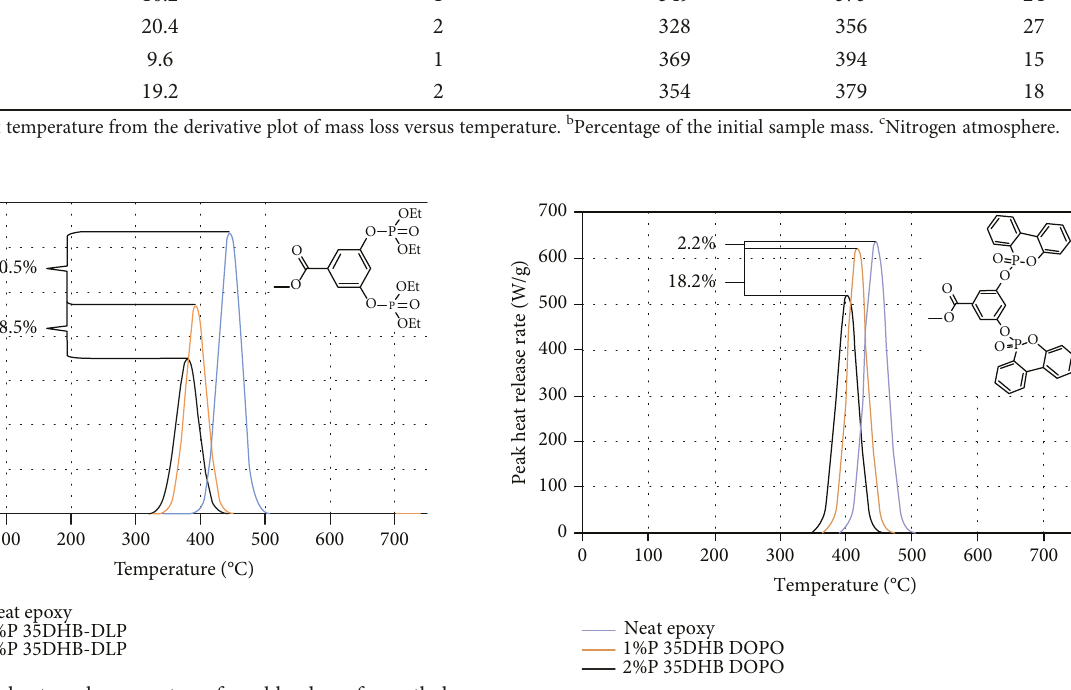
Figure 7: Peak heat release rates for blends of methyl 3,5-di(dopyloxy)benzoate in DGEBA